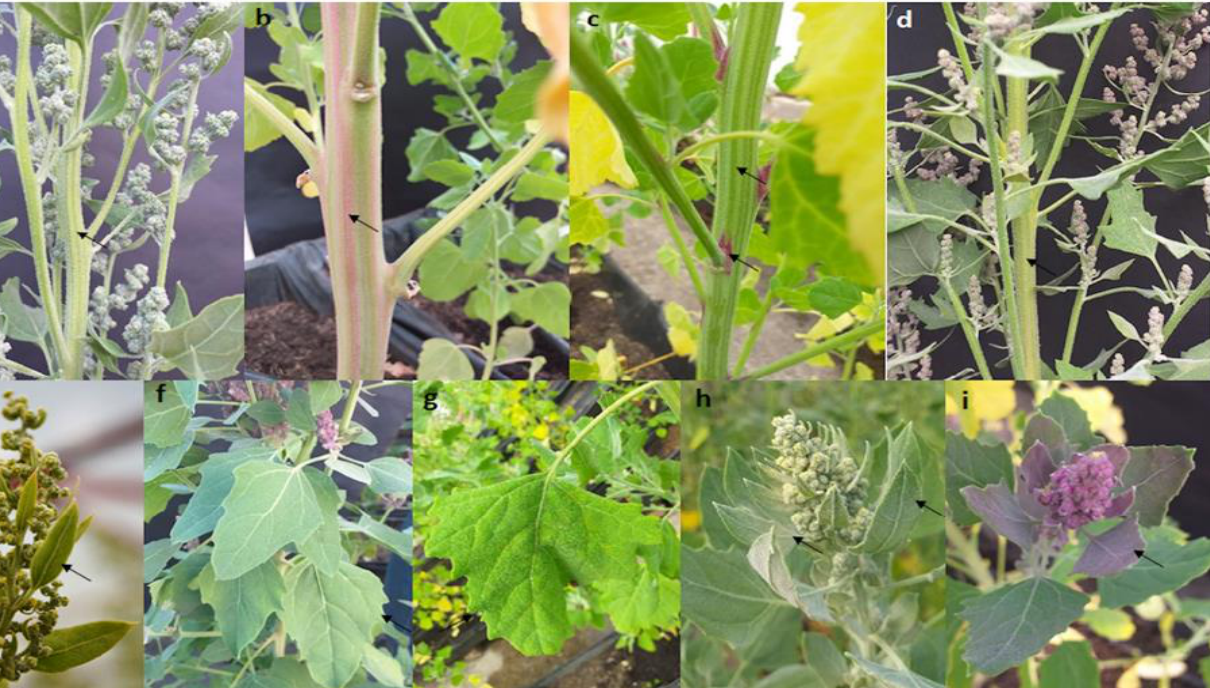
Figure 3. ( a ) Angled stem with green striae; ( b ) Purple striae; ( c ) Stem with green striae and purple axillae; ( d ) Stem with green striae and no axillae; ( e ) Apical leaves with lanceolate and entire shape; ( f ) Leaves with rhomboid shapes and serrated edge; ( g ) Triangular shaped leaves with serrated edge; ( h ) White calcium oxalates on the upper surface and underside of the leaf; ( i ) Pink calcium oxalates on the upper surface of the leaf.